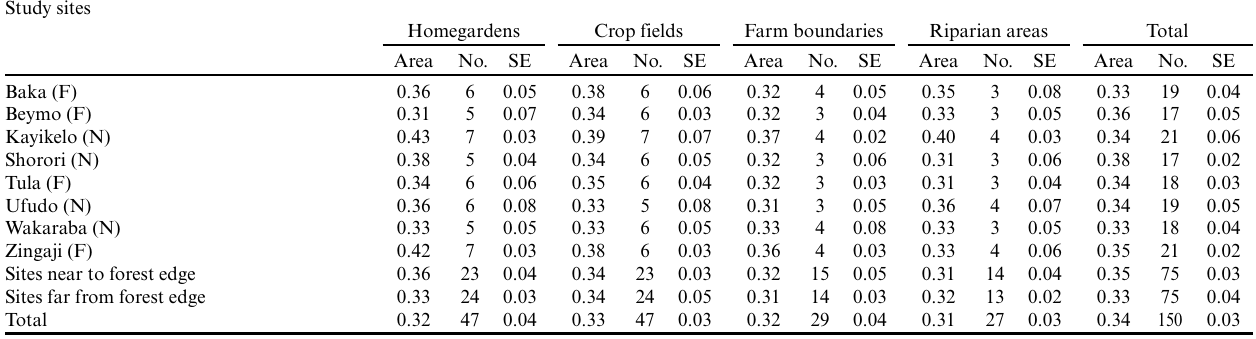
Table 2. . Average size (in ha) and number of the investigated fields at different proximities from the forest edges: N = study sites near to the forest edge; F = study sites far from forest edge.